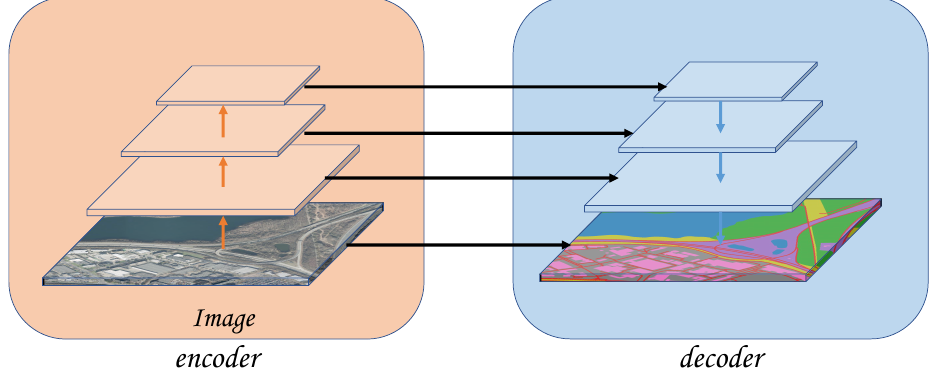
Figure 2. Semantic Segmentation